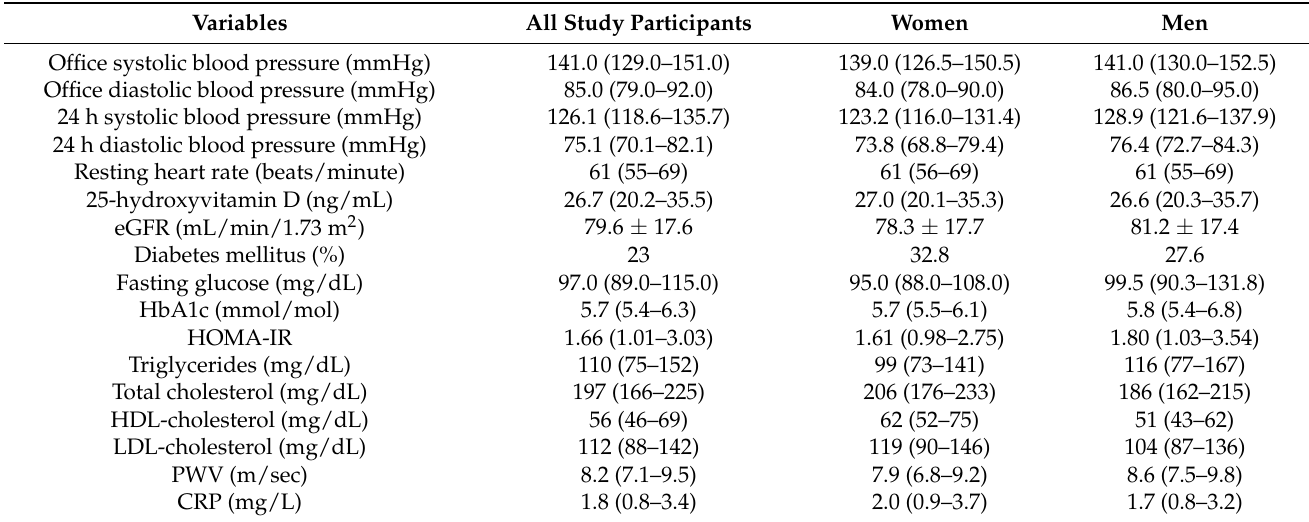
Table 2. Haemodynamic and metabolic parameters of all study